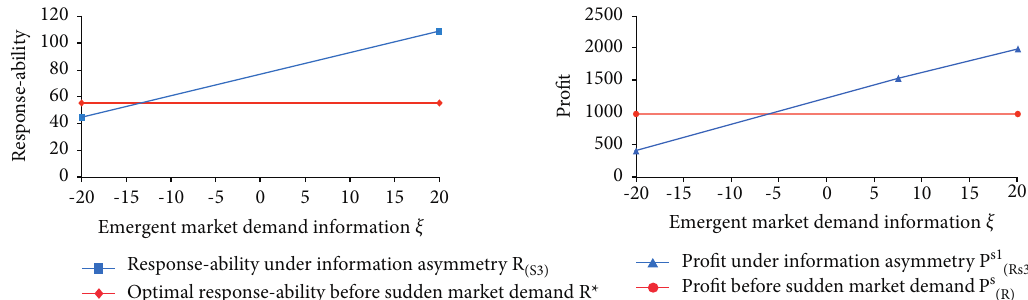
Figure 3: The change of supply chain’s profit and response ability under asymmetric information before and after an emergency.